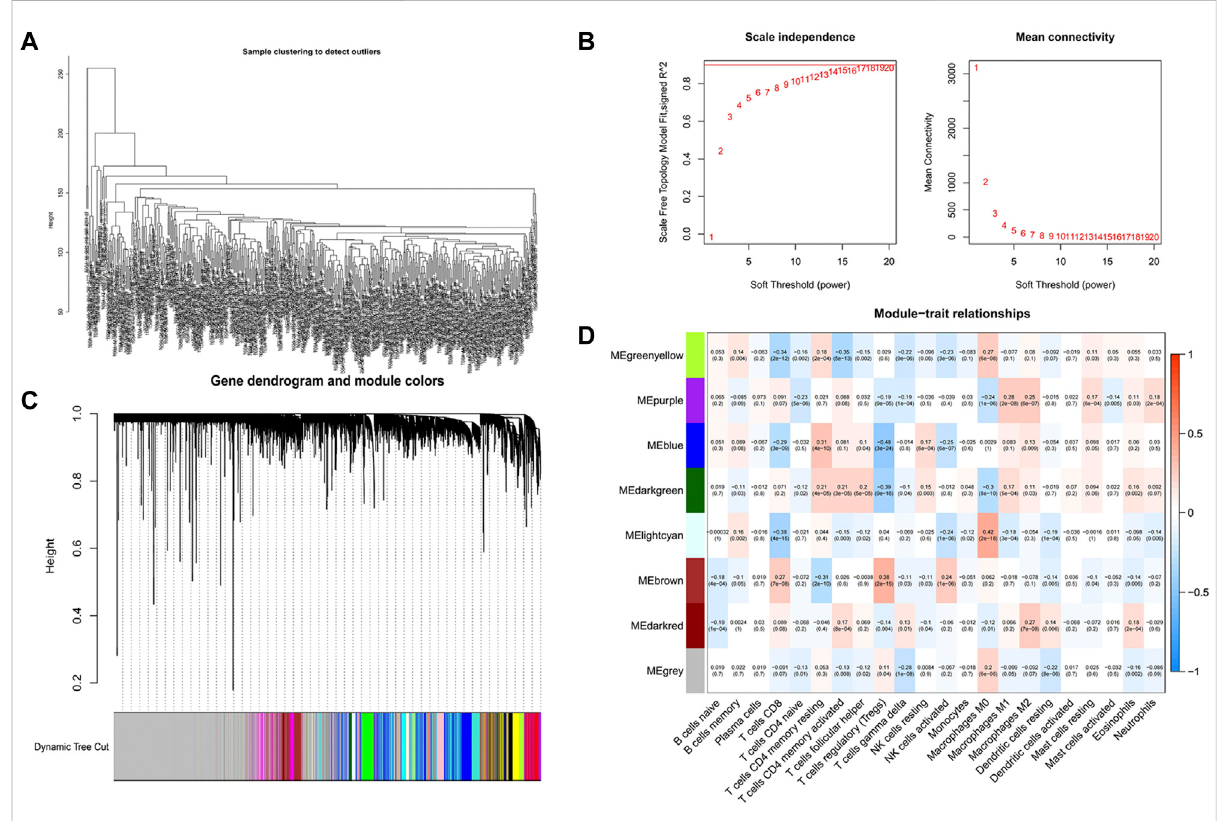
FIGURE 3 Screening of CD4 + MTC-related co-expression modules. (A) Sample clustering of WGCNA. (B) Scale-free fi t index and average connectivity of the1 – 20softthresholdpower( β )wereanalyzed. (C) Hierarchicalclustering treeofgenesbasedonthetopological overlap.Differentcolorbranches of the cluster tree represent different modules. (D) Correlation between CD4 + MTCs and genes in each